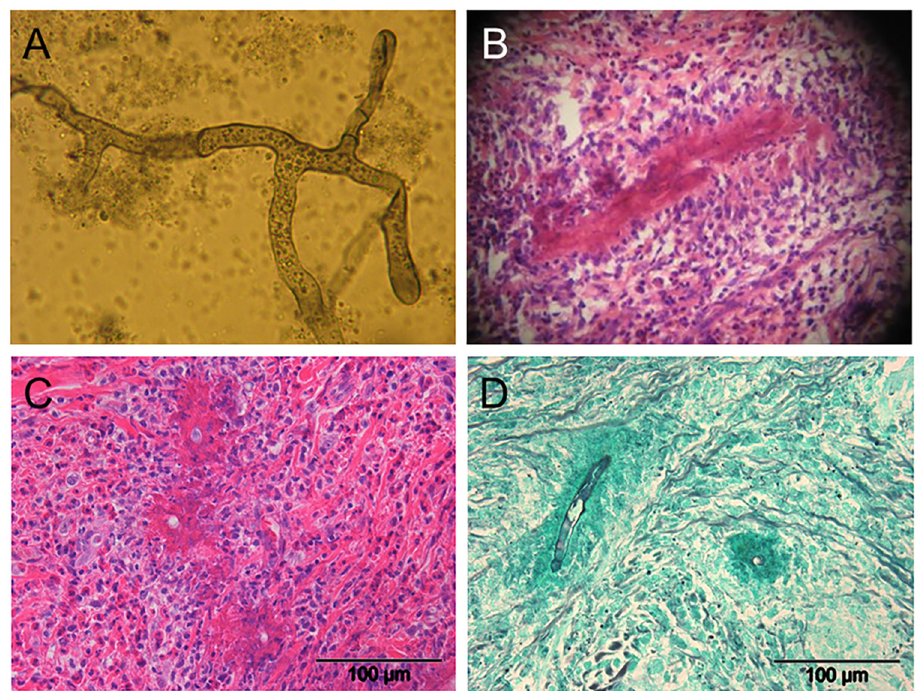
Fig 3. Histopathology. Histopathological picture of hyphae of Entomophthorales after KOH-staining (A), after hematoxylin eosin stain (HE-stain) (B and C), and after Grocott-Gomori's methenamine silver stain (GMS-stain) (D). The pauci-septated, right-angled branching fungal hyphae have an irregular diameter of 5 – 12 μ m with drumstick-like distended ends (A). The “ Splendore-Hoeppli phenomenon ” is characterized by a peri-hyphal amorphous eosinophilic material (B). Fungal hyphae are visible in transversal (C) or longitudinal cuts